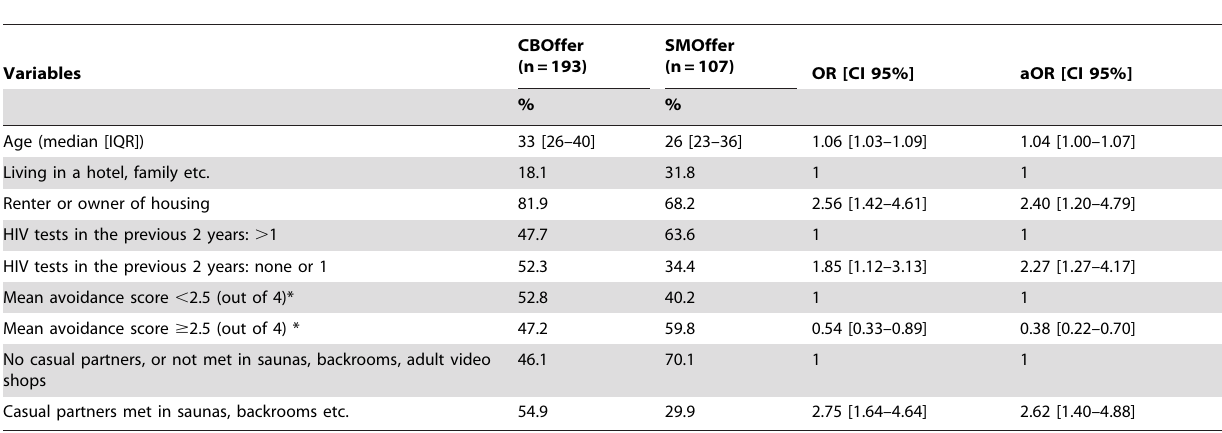
Table 3. Factors associated (OR) and independently associated (aOR) with accessing the community-based non-medicalized HIV testing offer (multivariate analyses controlling for all sites, p , 0.05, n=300).